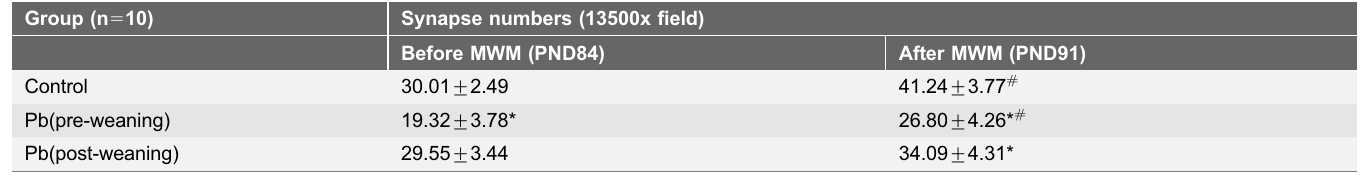
Table 4. The effect of developmental lead exposure on the number of synapses in the CA1 region of rat hippocampus. Group (n 5